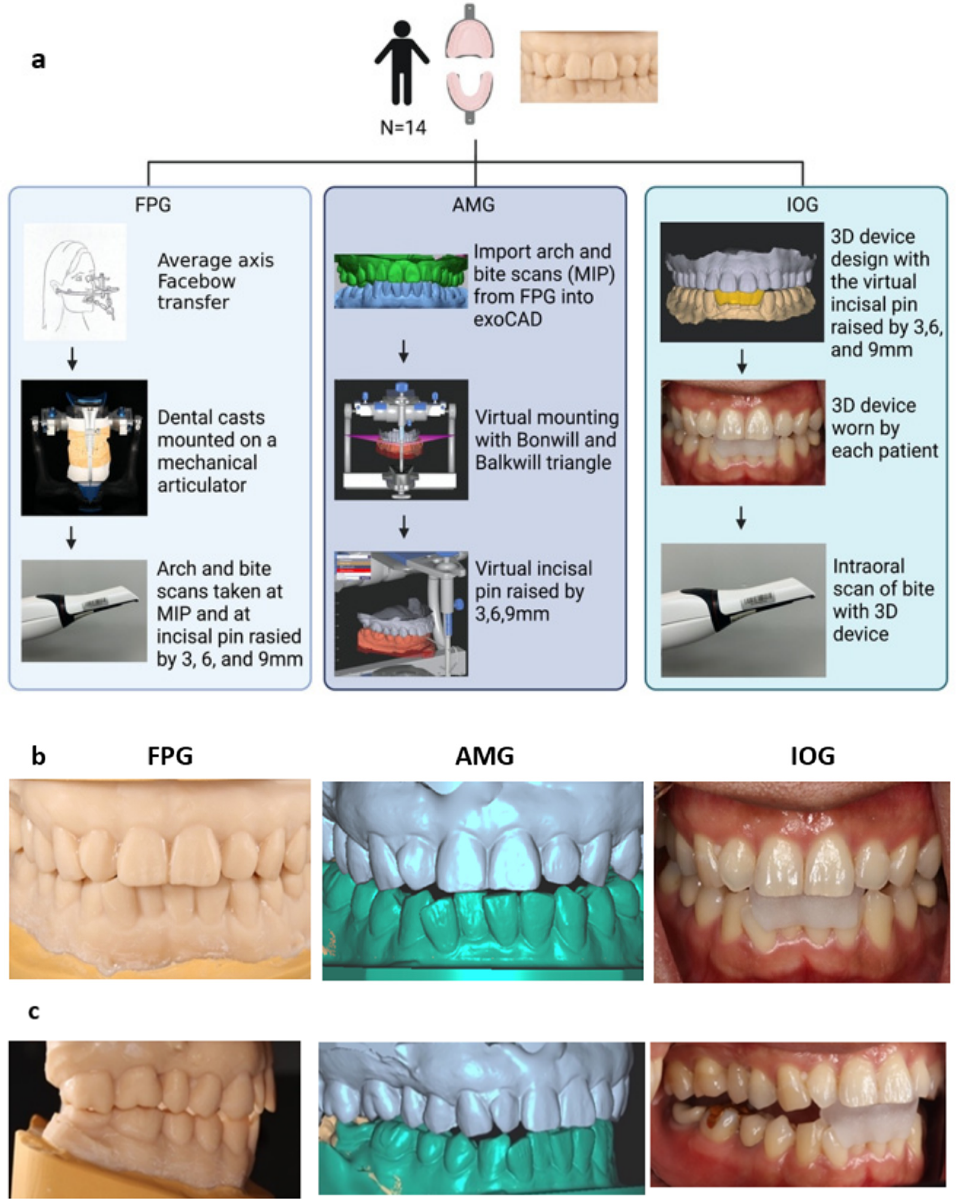
Figure 1. ( a ) Workflow for the facebow preservation group (FPG), average mounting group (AMG), and the intraoral group (IOG). ( b ) Anterior opening and ( c ) posterior opening when OVD + 3 mm. For the AMG, an intraoral scanner (3Shape TRIOS; 3Shape A/S) was used to capture the maxillary and mandibular arches and buccal scans of the casts mounted in the FPG. digital design software (exoCAD; exocad GmbH) and mounted digitally on a virtual Artex CR type A articulator by using the average values of the Bonwill triangle and the Balkwill angle. The incisal edge of the mandibular central incisors and mesiobuccal cusp tips of the mandibular first molars were the anterior and posterior reference point for the virtual mounting, respectively (Figure 2). All virtual mountings were performed with a 10° Ben- nett angle, a 35° condylar angle, a 23° Balkwill angle, a 110 mm arm, and a 0 mm imme- diate mandibular sideshift. Figure 2. Virtual articulation of the average mounting group (AMG) in the Exocad CAD ® software (v3.0). ( a ) MIP, frontal view. ( b ) MIP, 45-degree view. ( c ) Virtual incisal pin raised by 3 mm. For the control group, the intraoral group (IOG), three mandibular anterior devices (Figure 1) were virtually designed using the AMG in the exoCAD software program with the virtual articulator incisal guide pin raised by 3, 6, and 9 mm for each participant. Each device had a peripheral thickness of 1.5 mm covering the mandibular incisor teeth with occlusal stops opposing the palatal surfaces of the maxillary anterior teeth. The devices were 3D printed in clear resin (VisiJet M2R-CI; 3D Systems) with a 3D printer (ProJet MJP 2500 Plus; 3D Systems). The devices were tried for each participant and STL files of the buccal scans were directly obtained with a 3Shape Trios intraoral scanner. Anterior and posterior interocclusal measurements at an increased OVD in the FPG and AMG were recorded for a comparison to the measurements obtained from the IOG. For the FPG, the incisal guide pin was raised by 3, 6, and 9 mm in the mechanical articu- lator and STL files of the corresponding buccal scans were obtained with the same in- traoral scanner. For the AMG, the incisal guide pin was raised by 3, 6, and 9 mm in the virtual articulator and the interocclusal registrations were captured accordingly. For the IOG, the mandibular devices were tried for each participant and buccal scans were taken using the 3Shape Trios intraoral scanner. All interocclusal measurements within the FPG, AMG, and IOG were obtained and analyzed in the exoCAD software program by a single calibrated investigator (Y.L.). Anterior interocclusal measurements were taken from the midpoint of the maxillary right central incisal edge to the mandibular right central incisal